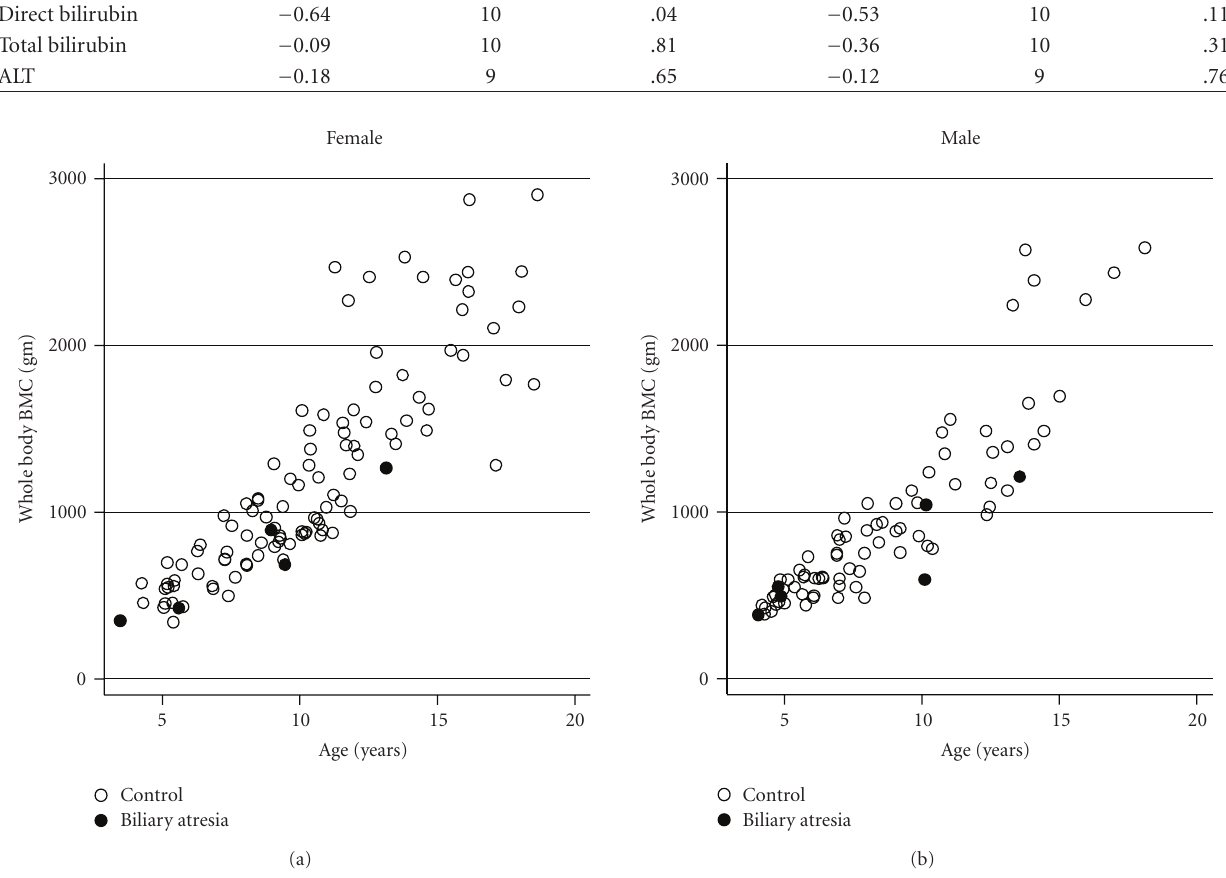
Figure 3: Age versus whole body bone mineral content in BA subjects compared to